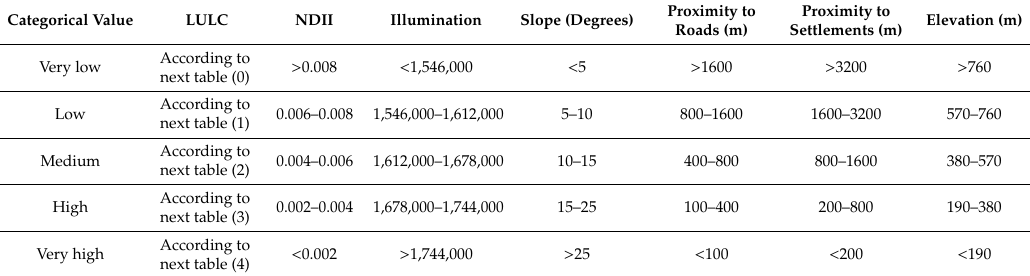
Figure 5. The flowchart of the work progress. Landsat-5 / 7 / 8 images were used for each one of the three fire incidents investigated in the current study and the flowchart, other than the use of a di ff erent Landsat image, which was identical for each case. Table 1. Factors and categorical values used in the model.